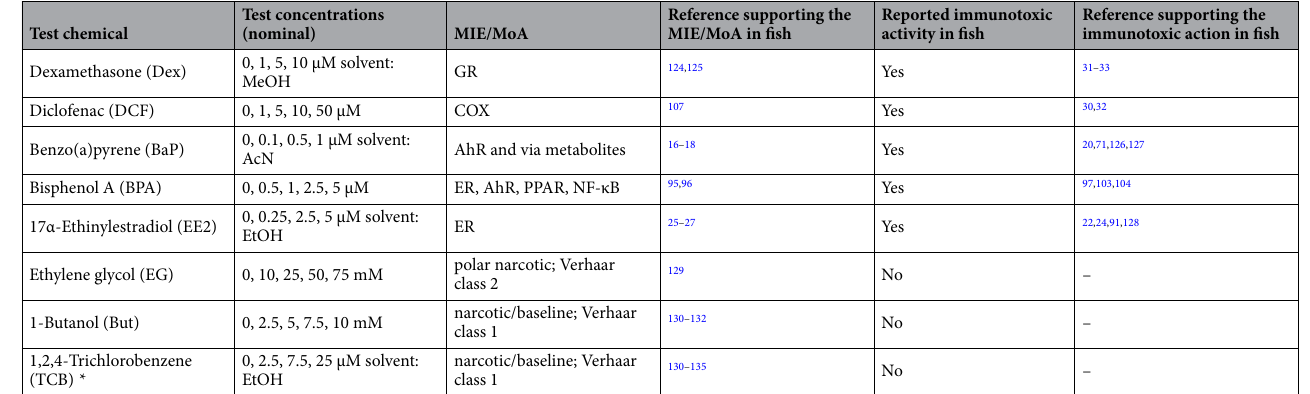
Table 1. Nominal concentrations of chemicals for assessing the immune parameters, and their molecular initiating event (MIE)/mode of action (MoA). MeOH methanol, AcN acetonitrile, EtOH ethanol, GR glucocorticoid receptor, COX cyclooxygenase, AhR aryl hydrocarbon receptor, ER estrogen receptor, PPAR peroxisome proliferator-activated receptor, NF-κB nuclear factor kappa-light-chain-enhancer of activated B cells. *TCB: the immuno-assay was conducted but results were excluded retrospectively since QASR modelling revealed a loss to air of about